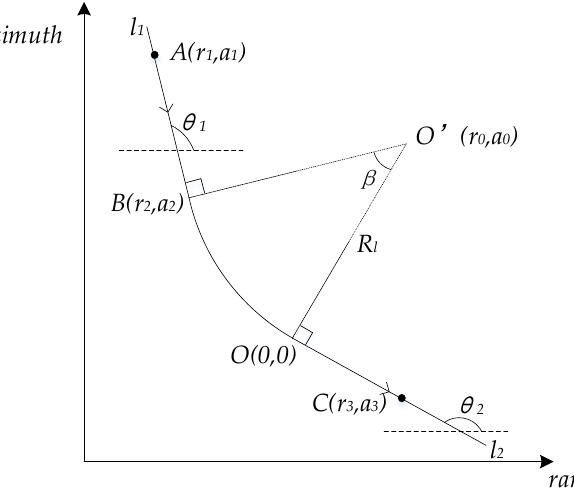
Figure 2. Geometric model of turning motion targets.